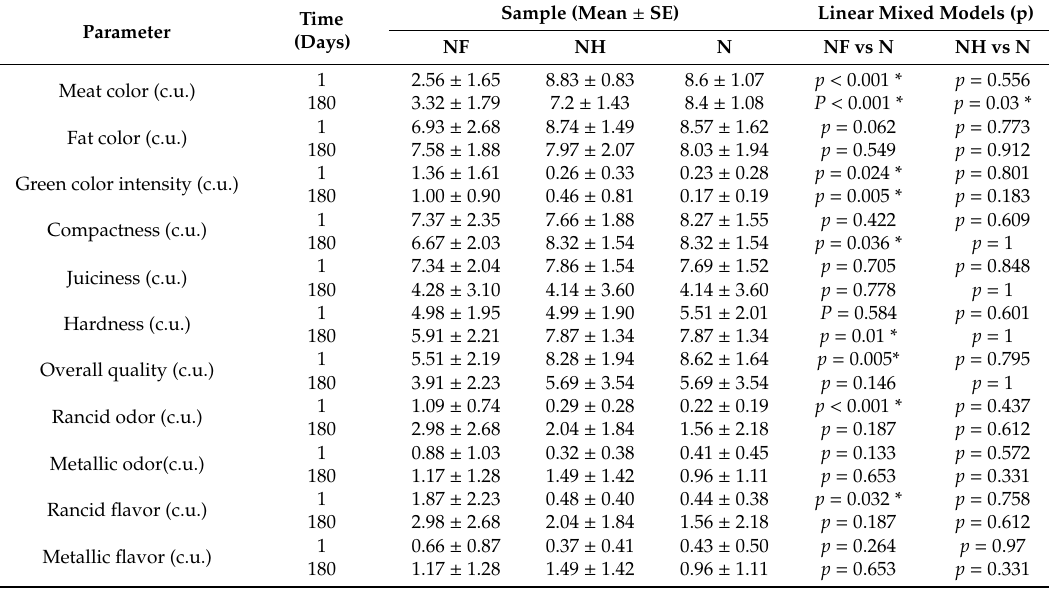
Table 7. Sensory analysis of canned pork with reduced amount of nitrite during storage. Time Parameter